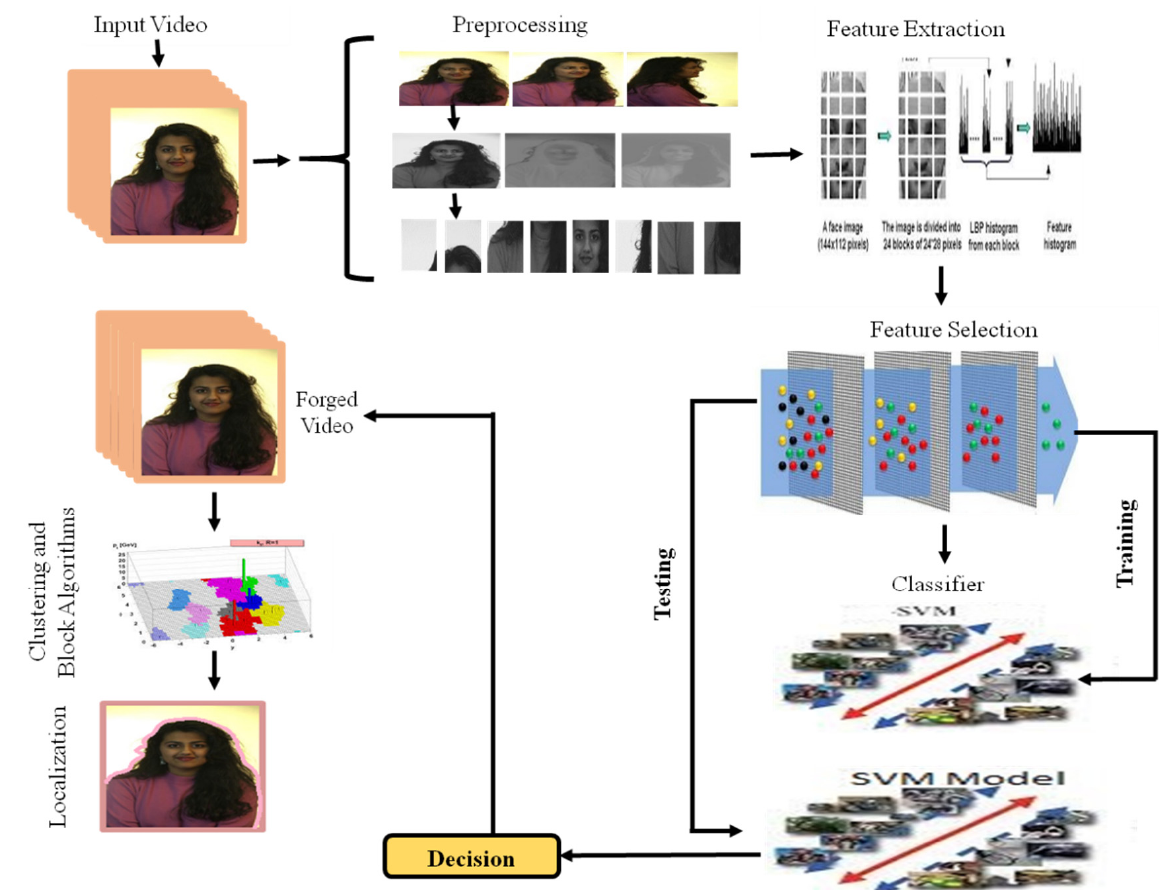
Figure 7. Process of video tampering detection and localization.